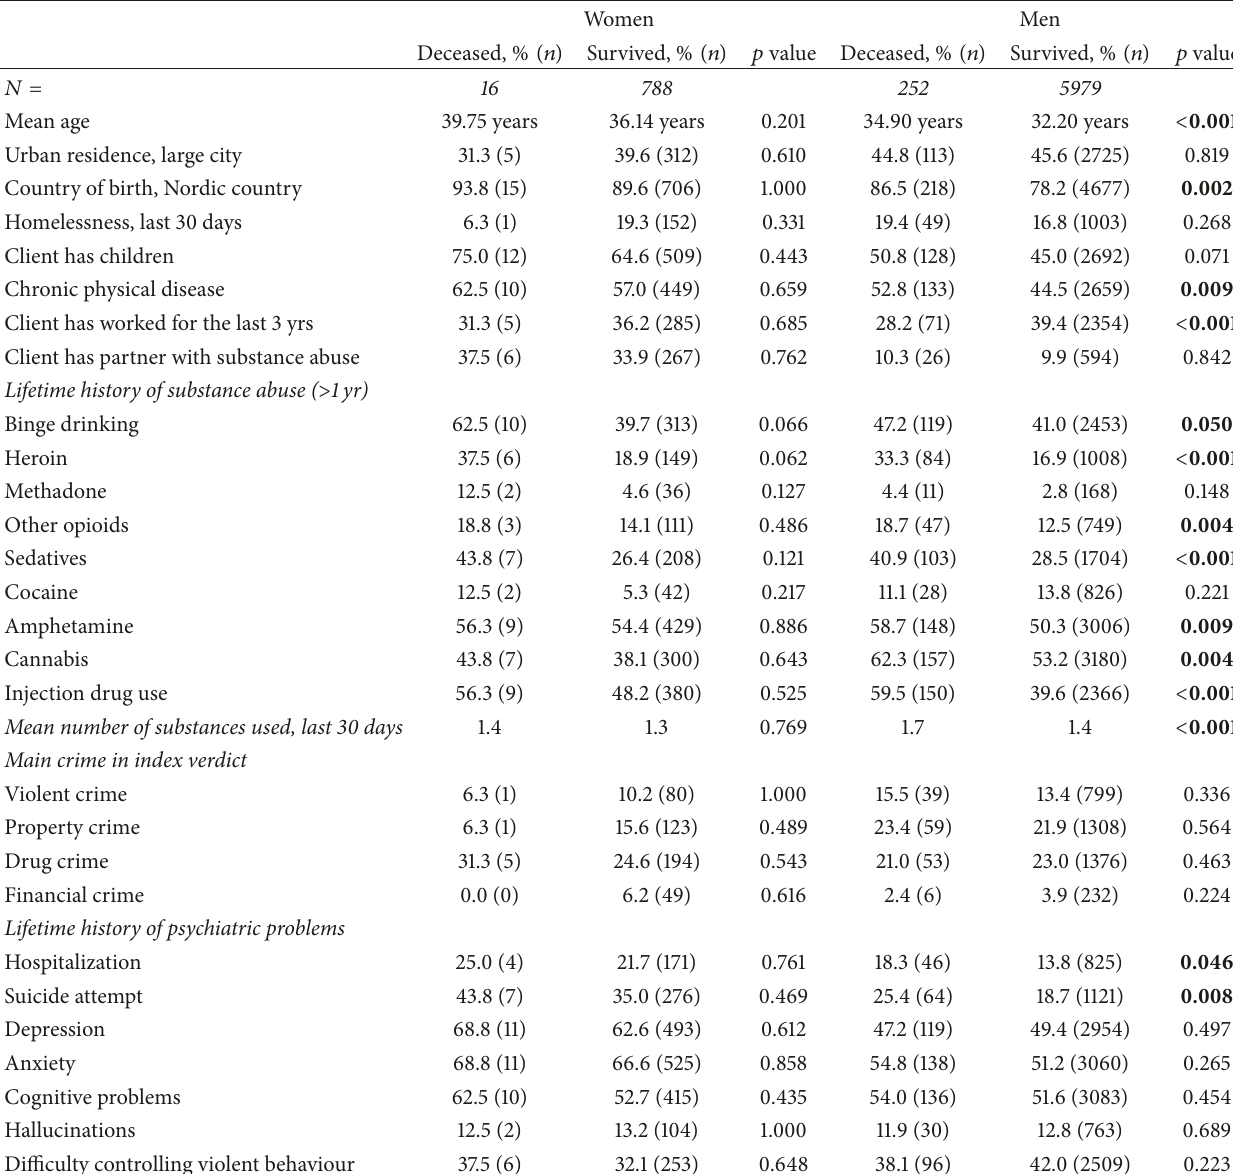
Table 2: Characteristics according to mortality status. Women